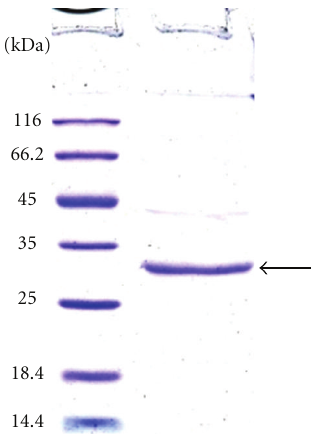
Figure 3: 15% SDS-PAGE of the purified target protein. The arrow indicates the target protein ApE1 with predicted mass of 30 kDa. Molecular weight markers are shown at the